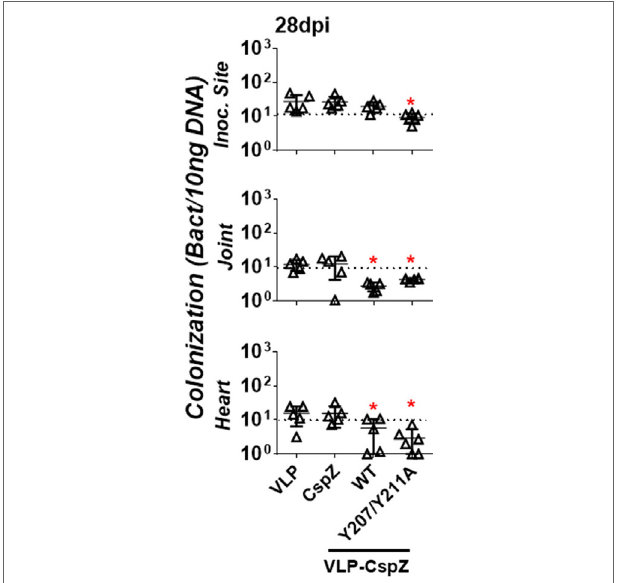
FigUre 6 | Vaccinating mice with VLP-CspZ-Y207A/Y211A eliminated Borrelia burgdorferi tissue colonization compared to virus-like particle (VLP) or VLP-CspZ immunization. C3H/HeN mice were immunized with VLP (“VLP”), CspZ (“CspZ”), or VLP-CspZ (“VLP-CspZ-WT”, five mice per group), or VLP-CspZ-Y207A/Y211A (“VLP-CspZ-Y207A/Y211A”, six mice per group) and subsequently infected with 10 4 B. burgdorferi strain B31-A3. Spirochete colonization at inoculation site of skin (“inoc. site”, top panel ), knee joint (“joint”, middle panel ), and heart (“heart”, bottom panel ) was quantitatively measured 28 days post infection. Colonization was derived by normalizing the number of spirochetes detected by quantitative PCR to 10 ng total DNA. Data shown are the mean ± SD, of five (VLP, CspZ, VLP-CspZ) or six (VLP-CspZ-Y207A/Y211A) mice. Statistical significance ( p < 0.05) of differences in bacterial burden relative to VLP-immunized mice was determined using a one-way ANOVA test and post hoc analysis and are indicated